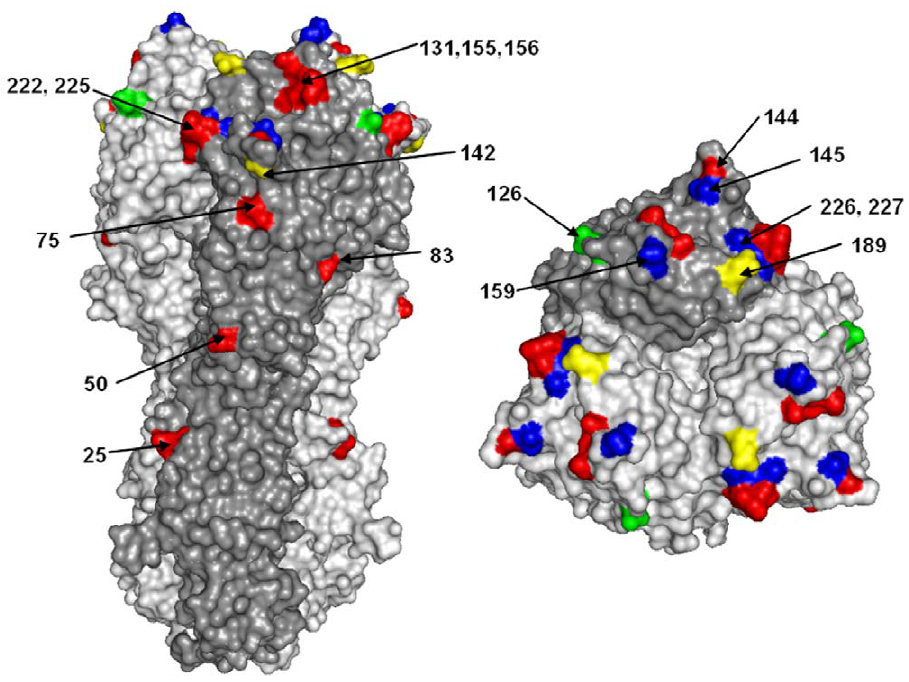
Figure 6. Surface representation of the hemagglutinin hetero-trimer from a seasonal H3N2 strain [ 47 ] . Location of the amino acids substitutions marking the transition between Panama-like and Fujian-like viruses are highlighted in red; those changes which differentiate viruses isolated since 2004–2005 from Fujian/411-like viruses are coloured in blue; genetic group I-specific changes are highlighted in green and genetic group II-specific changes are marked with yellow.